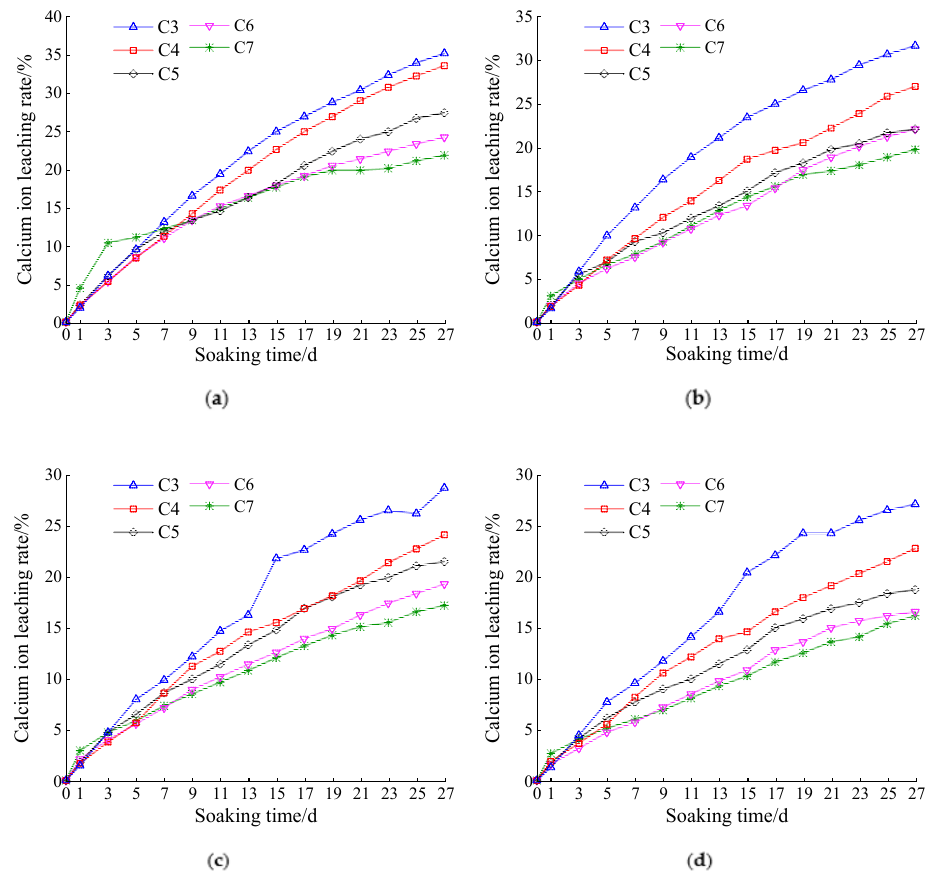
Figure 5. Variation curves of Ca ion dissolution rate at different cement dosages: ( a ) cement:fly ash = 1:0; ( b ) cement:fly ash = 1:0.1; ( c ) cement:fly ash = 1:0.2; ( d ) cement:fly ash = 1:0.3.